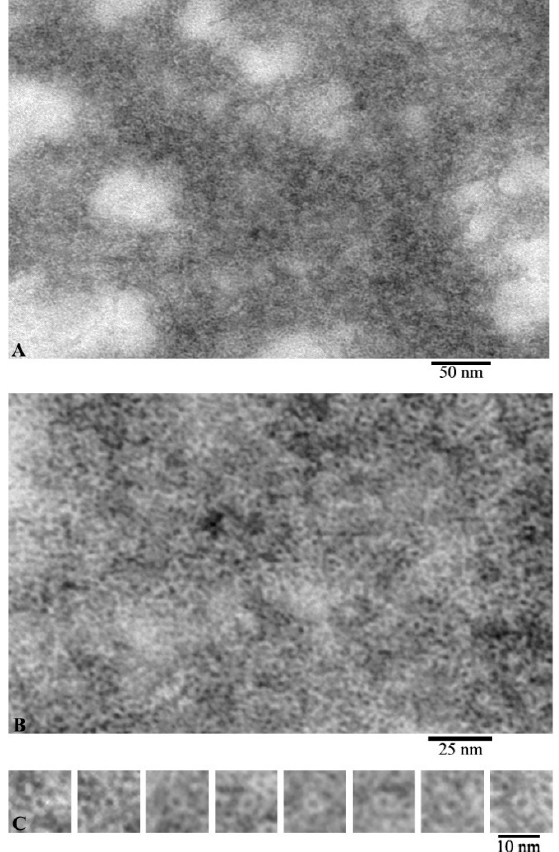
Figure 1. Images of G-actin obtained by electron microscopy. Field ( A ), fragment of high magnification field ( B ) and single molecules of monomeric actin ( C ).